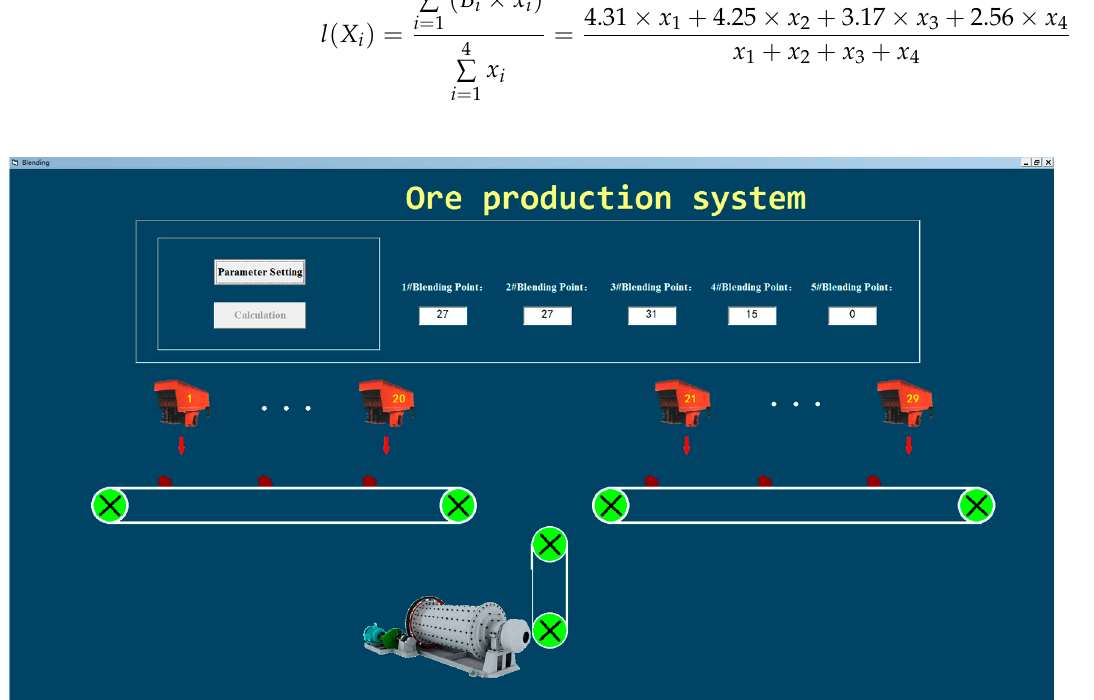
Figure 5. Interface for blending parameters setting.